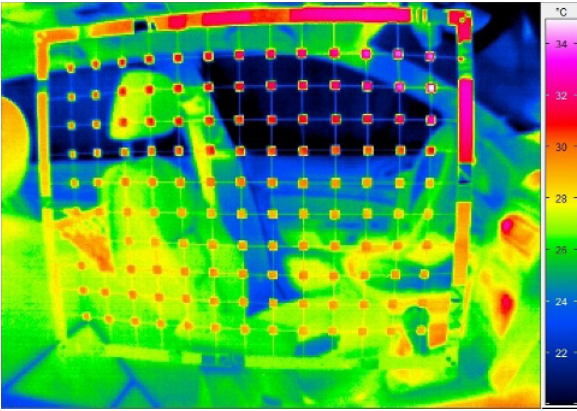
Fig. 11. The original thermogram of the hot air stream measuring in the front passenger area by hand-held measuring